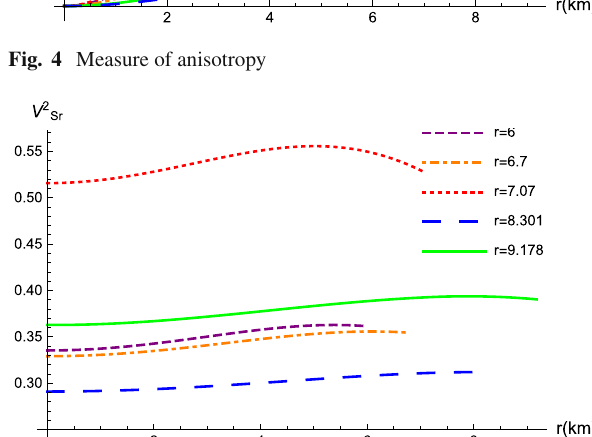
Fig. 1 Energy density